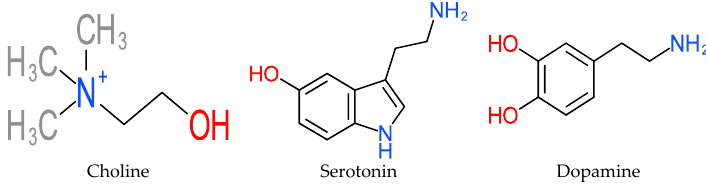
Figure 21. Structures of Catecholamines.